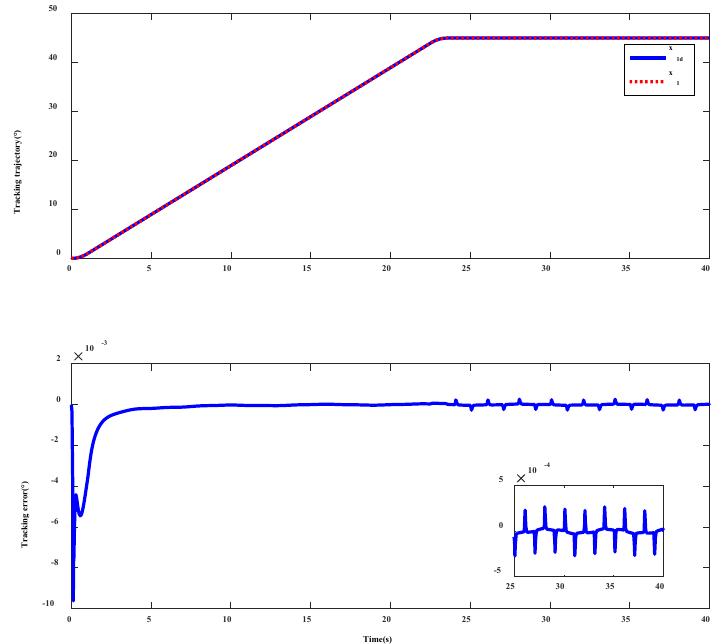
Figure 3. The tracking performance of the ADRAC.